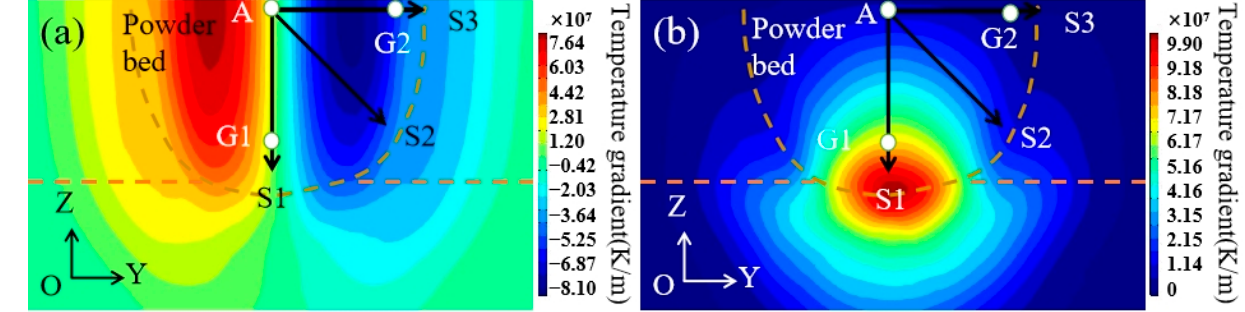
Figure 7. Simulated temperature gradients along the ( a ) Y direction for the melting pool (Gy); ( b ) Z direction for the melting pool (Gz).